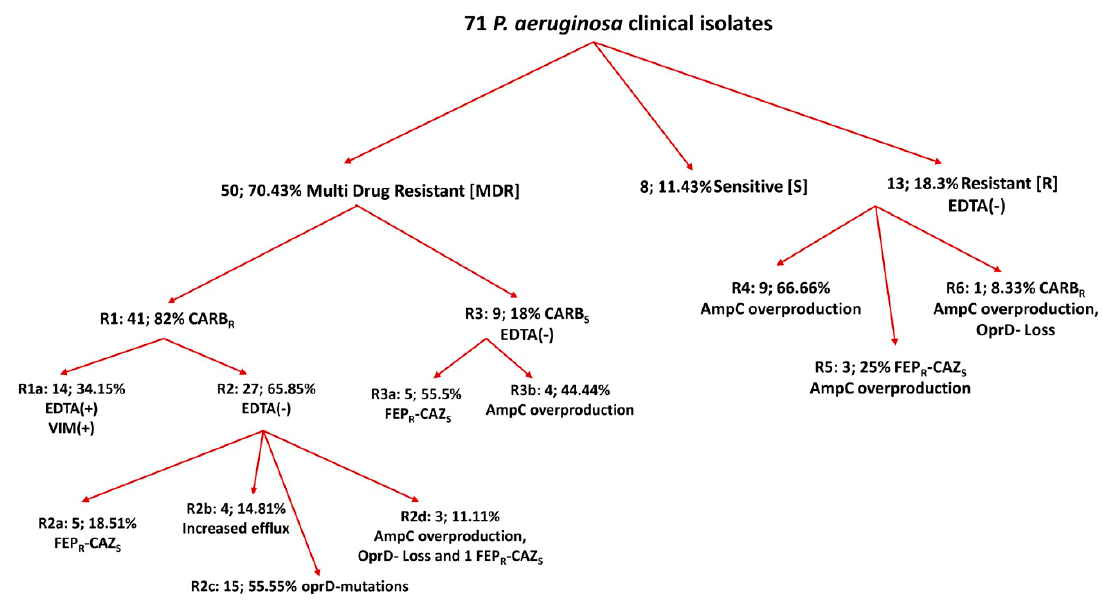
Figure 1. Resistant profiles of the 71 clinical P. aeruginosa isolates.